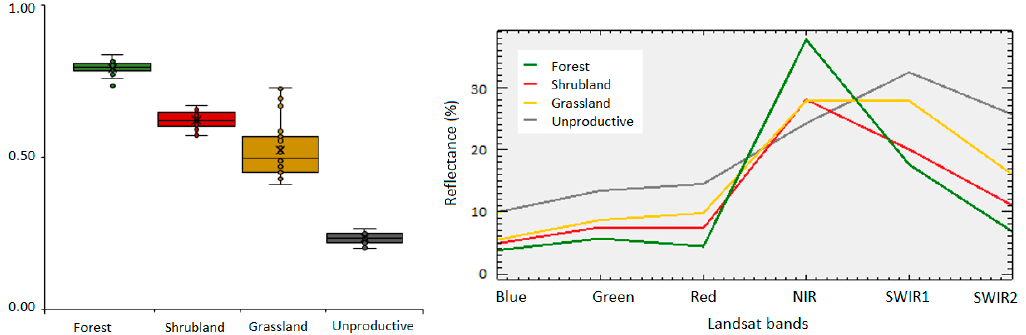
Figure 3. Spectral properties of the defined land cover classes (wooded, shrubland, grassland, and unproductive). Left: boxplot showing the medians and interquartile ranges for the different classes calculated with the annual mean values for the 1990–2020 series (n = 31). Right: spectral signatures corresponding to the ROI polygons from the Landsat 5 image of 10 August 1990.